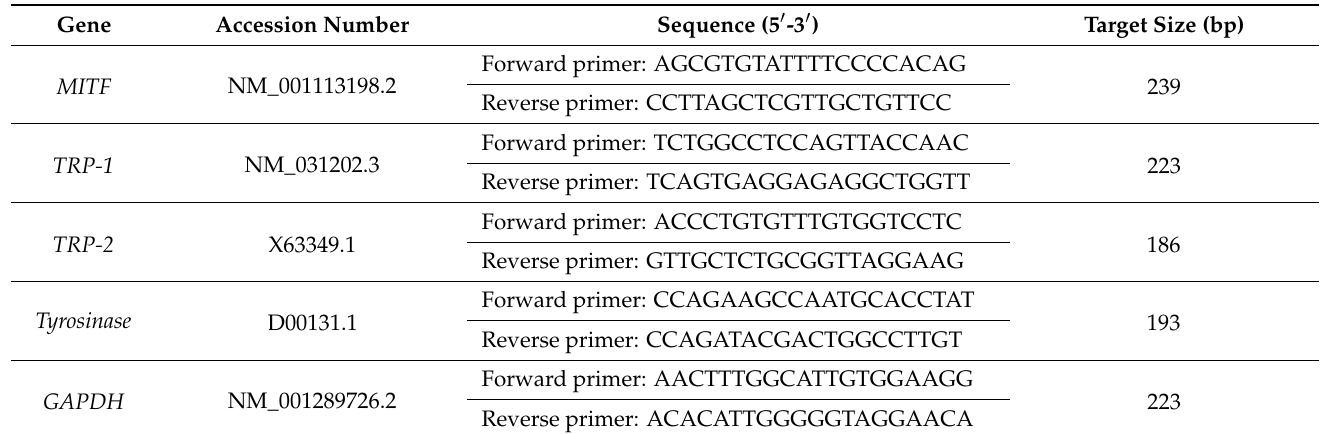
Table 1. Nucleotide sequences of the primers used in this